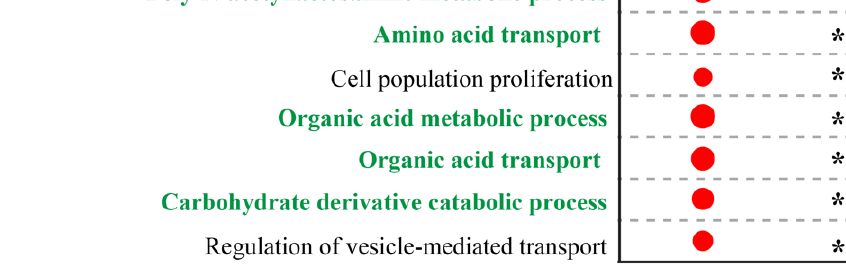
Figure 6. Pathways significantly enriched in lactate treatment compared with control treatment. NES: normalized enrichment score. Negative NES (blue dot) shows downregulated pathways and positive NES (red dot) shows upregulated pathways in lactate treatment, green-highlighted pathways are significantly altered both at the metabolic and transcriptomic levels, * Adjusted p < 0.05, ** Adjusted p < 0.01.